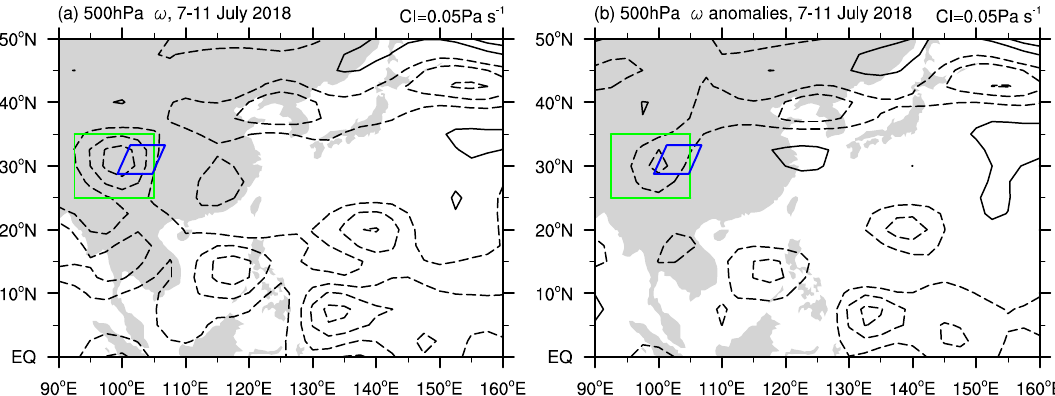
Figure 5. The ( a ) 500 hPa omega (CI = 0.05 Pa s − 1 ) and ( b ) anomalies of 500 hPa omega (CI = 0.05 Pa s − 1 ) averaged over 7–11 July 2018. The blue parallelogram and the green rectangle are the same as those in Figure 3.